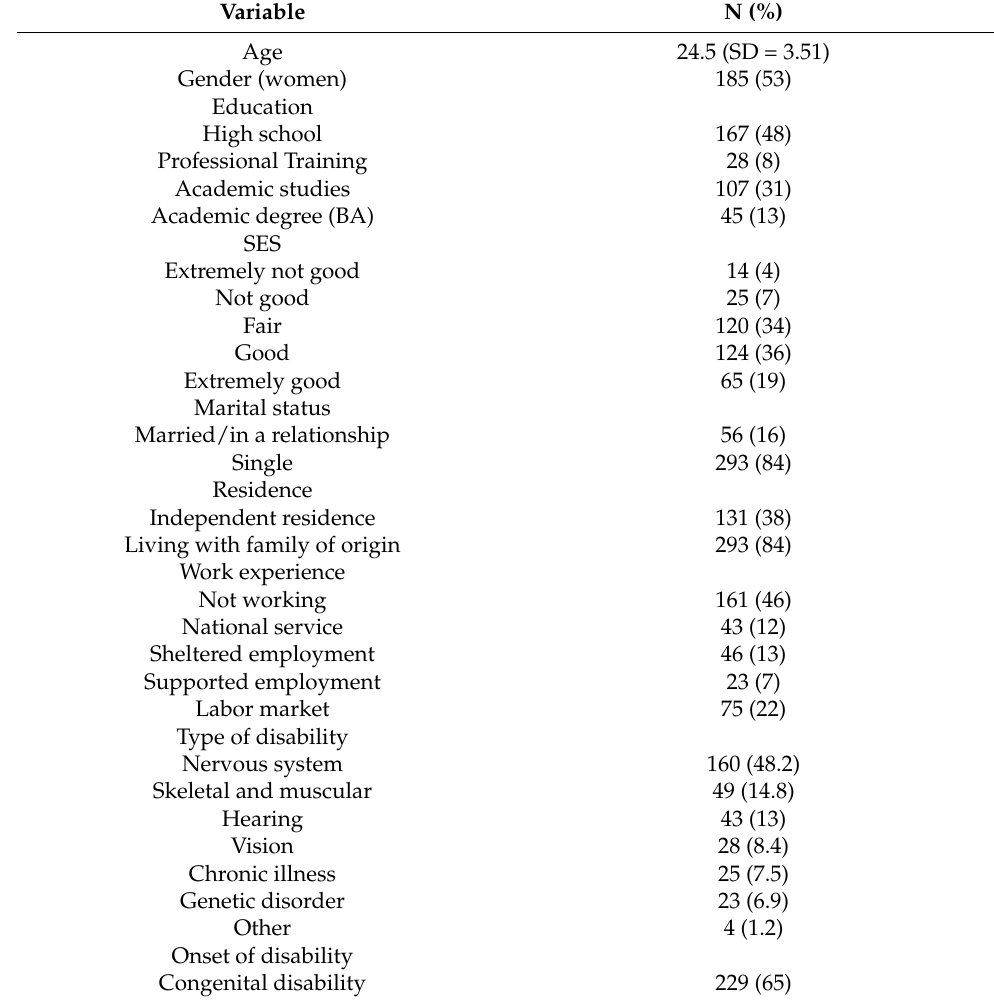
Table 1. Participants’ demographic